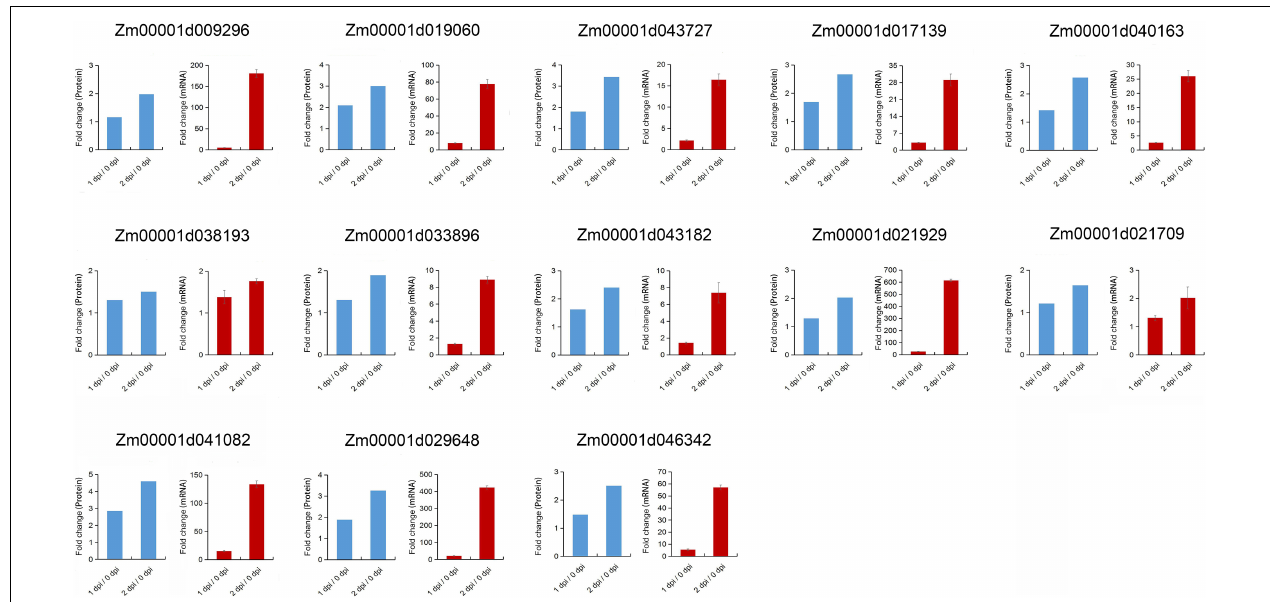
FIGURE 7 | Correlation between proteomics and qRT-PCR results of the proteins enriched in terpenoid backbone and diterpenoid biosynthesis pathway. Error bars represent SD from the